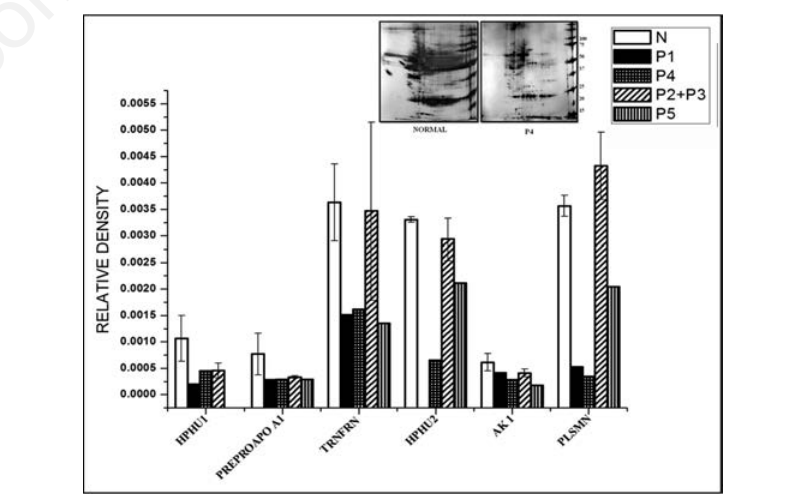
Figure 2. Histogram plots showing change in relative densities of the 6 differentially reg- ulated proteins in the plasma fraction. Since this was a case study, statistical analysis on the test samples were not done. Deviations from the mean of two normal (empty bar) and homozygous E (in slanted striped bar) samples are shown. The inset shows a 2D gels of normal and P4. N, normal; P1, father; P4, younger son; P2+P3, averaged P2 (mother) and P3 (elder son); P5, unrelated HbE- b -thalassemic sample; HPHU1, haptoglobin pre- cursor 1, PREPROAPO A1, preproapolipoprotein A1, TRNFRN, transferrin; HPHU2, haptoglobin precursor 2; AK 1, adenylate kinase 1; PLSMN,